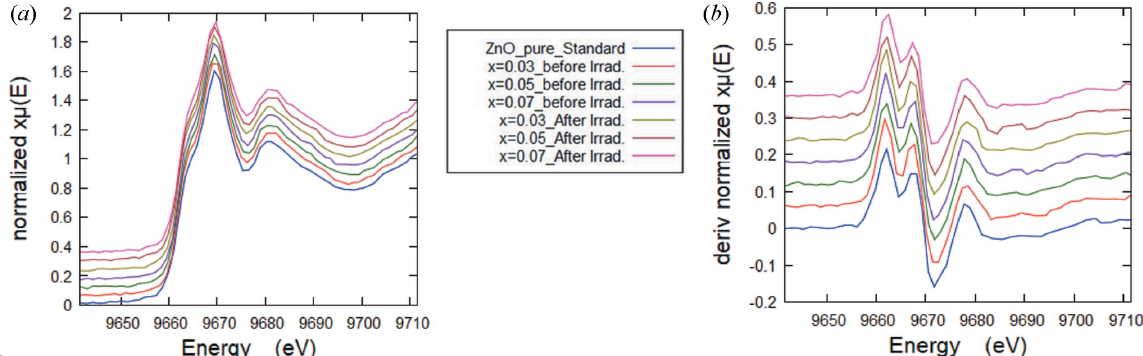
Figure 2 ( a ) Normalized XANES spectra of Mn-doped ZnO samples before and after irradiation, aligned vertically for clarification. ( b ) First derivative of the Zn K -edge XANES spectra with y -offset, compared with the first-derivative XANES spectrum of the ZnO standard